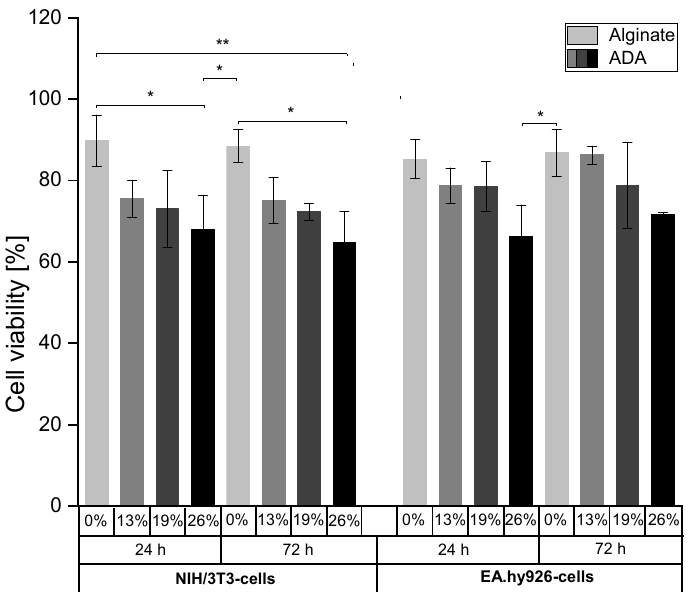
Figure 3. Cell viability of NIH/3T3- (left) and EA.hy926-cells (right) embedded in alginate and ADA hydrogels (%DO: 13–26%) after incubation for 24 h and 72 h. * p < 0.05, ** p < 0.01.